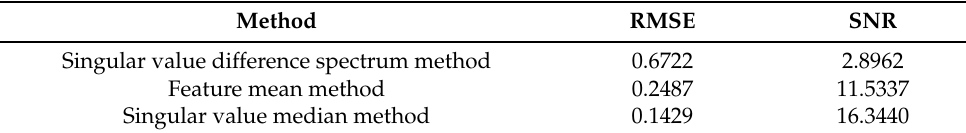
Table 1. Comparison of noise reduction effects of three